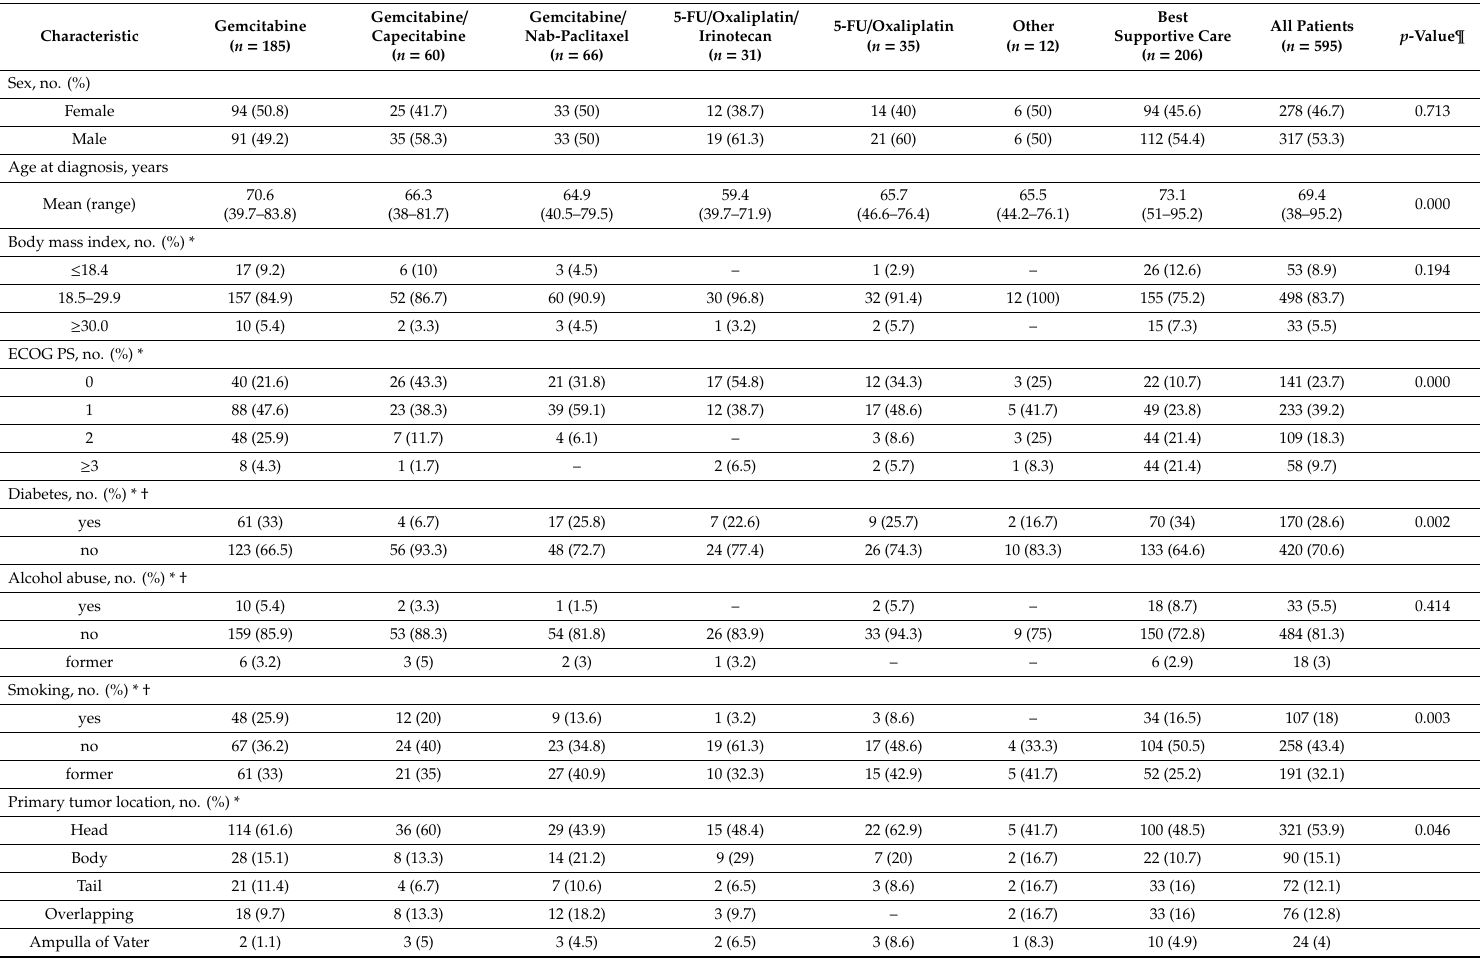
Table 1. Baseline characteristics of patients according to first-line